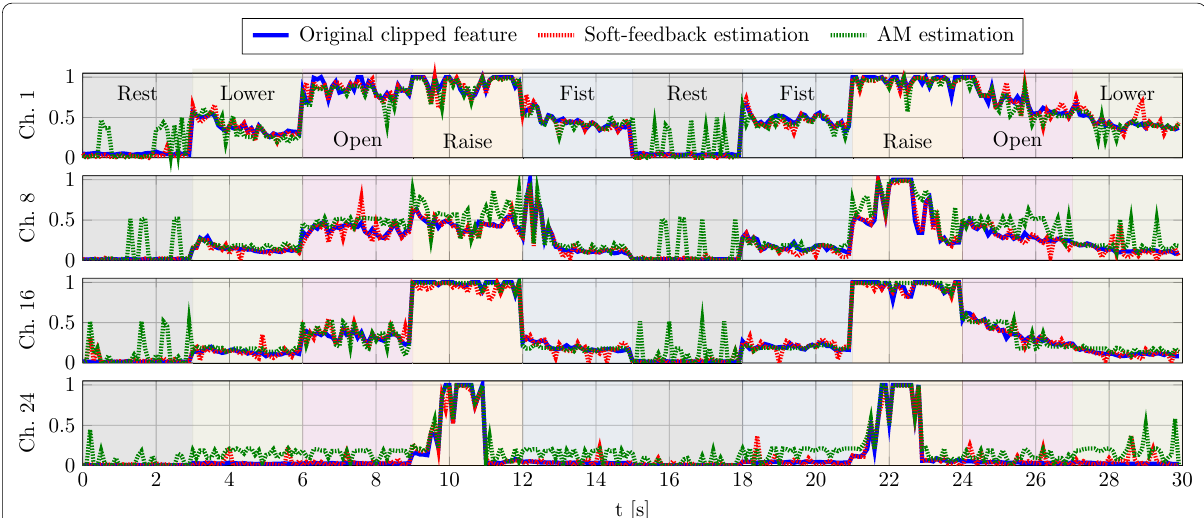
Fig. 15 Original and reconstructed EMG features of subject one with D = 1024 and 5 dB SNR. Ten gesture trials of 3 s length are concatenated; the break between trials was removed. Displayed, reconstructed signal has − 25.1 dB MSE with soft-feedback decoder and